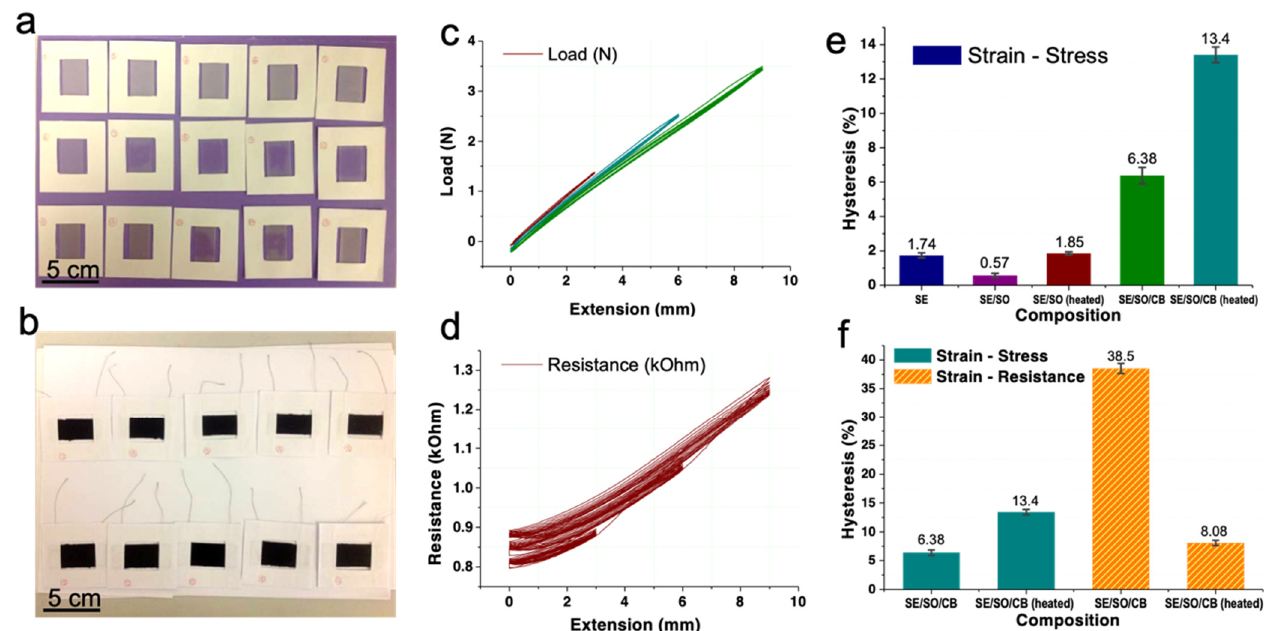
Figure 2. ( a , b ) Pictures of sample #1 to #25 fixed in cardboards. They were rowed as in Table 2. ( c ) The extension-load curves of sample #1. ( d ) the extension-resistance curves of sample #25. ( e ) Mechanical hysteresis of all the samples. ( f ) Comparison between mechanical and electromechanical hysteresis of the samples.